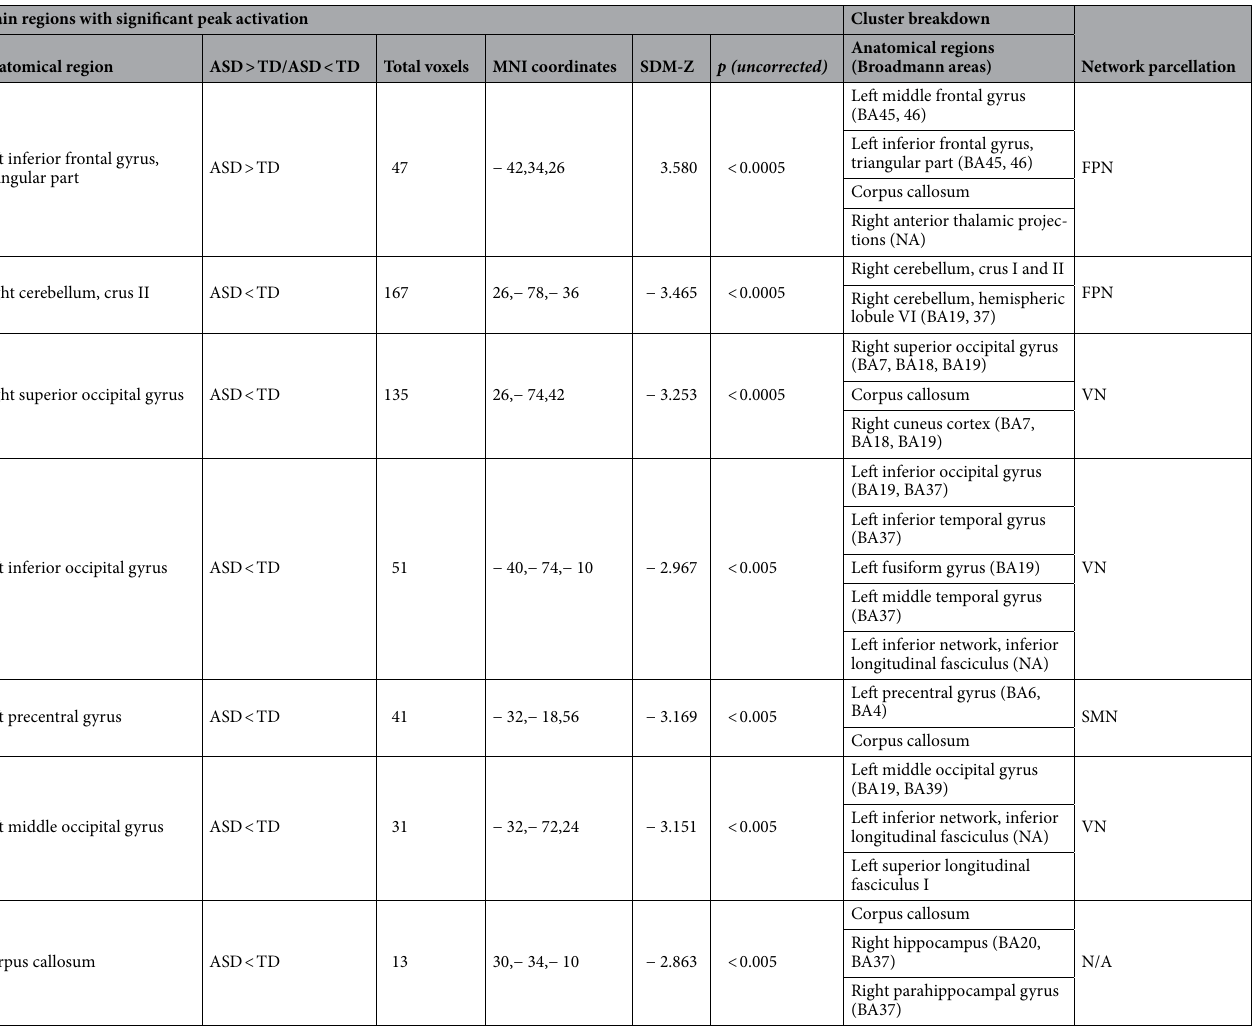
Table 2. fMRI meta-analysis on EC components (attention) with age as a